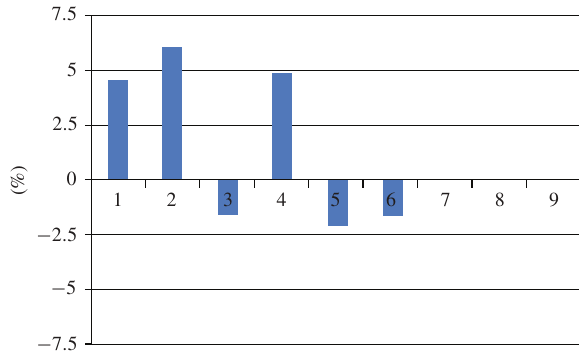
FIGURE 5: Stalk growth in the winter/spring experiments. For further explanations see Figure 4 and text.